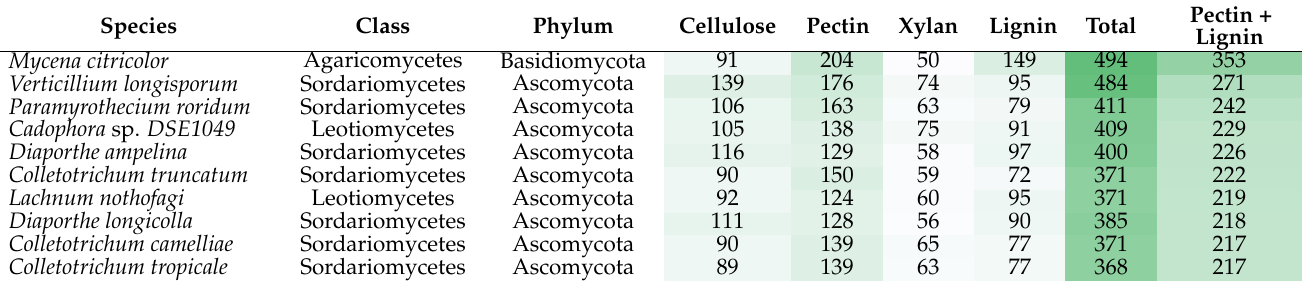
Table 3. Enzyme profile of the 10 species with highest “Pectin+Lignin” biomass degrading capacity. Number of Pectin plus lignin observations is listed in right hand column. One basidiomycete ( M. citricolor ) and one Ascomycete ( V. longisporum ) stands out to be unique among all 1932 species analyzed. The heatmap shows the highly varying enzyme profile found in the species with highest total degrading capacity on pectin and